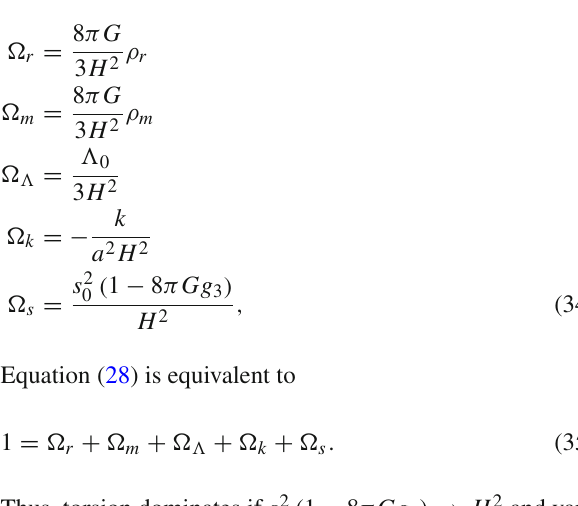
where (cid:18) i , 0 is the i -th density parameter evaluated at t = t 0